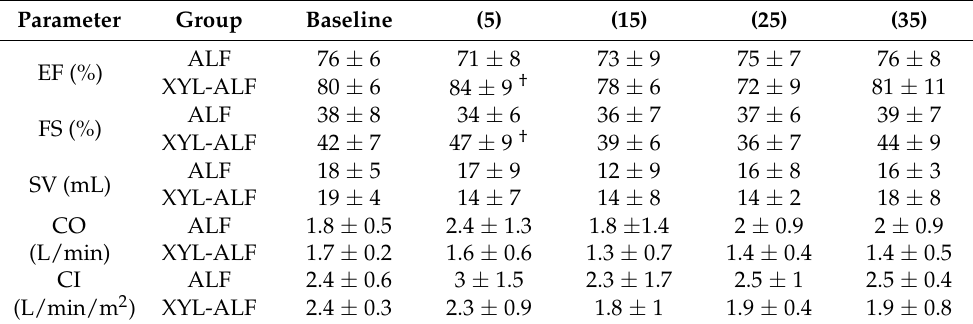
Table 3. Echocardiographic variables measured in goats at baseline and at 5, 15, 25 and 35 min